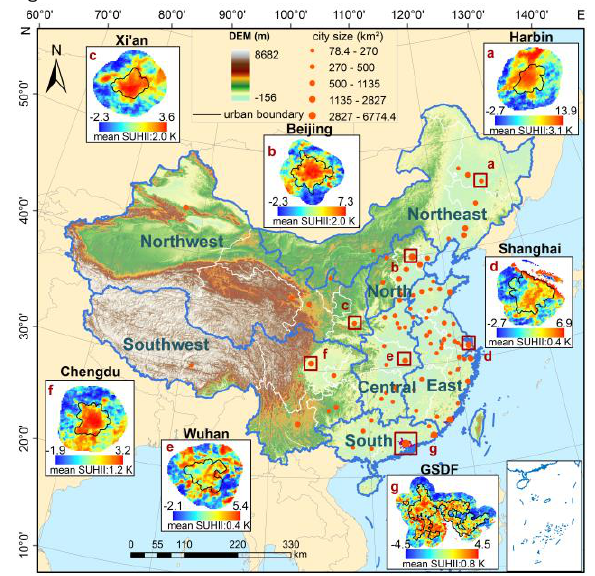
Figure 1. Geolocation of the chosen 86 cities over mainland China. Cities are given using red dots with different sizes to represent the associated city sizes. The seven selected megacities are labelled from (a) to (g). The spatial patterns of the annual mean nighttime SUHII for an entire city as well as for each pixel over these seven megacities are illustrated in the corresponding